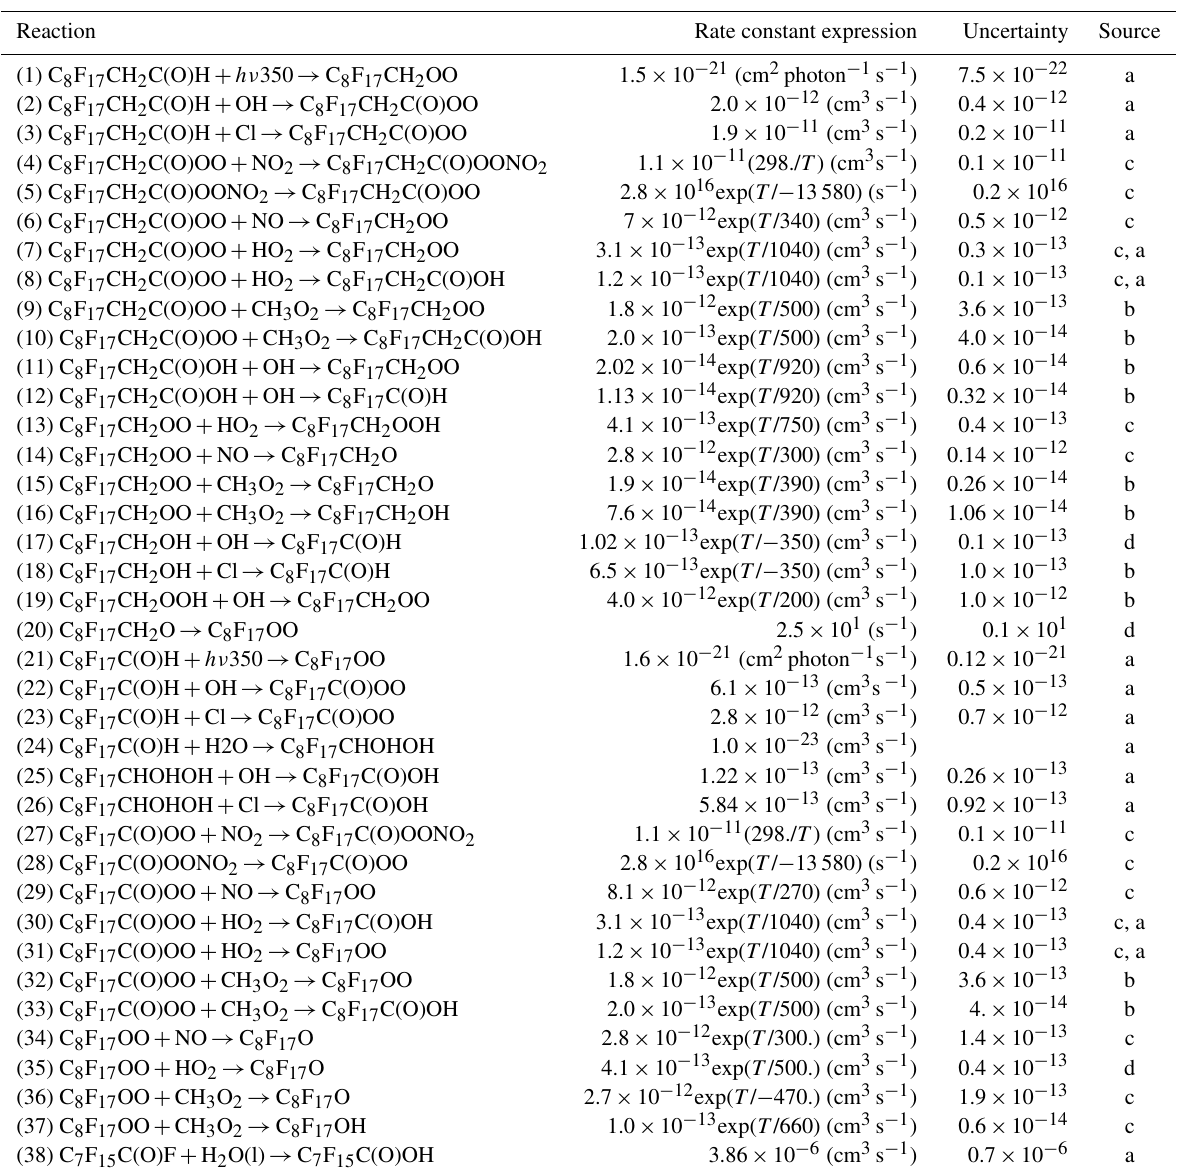
Table A1. List of reactions.